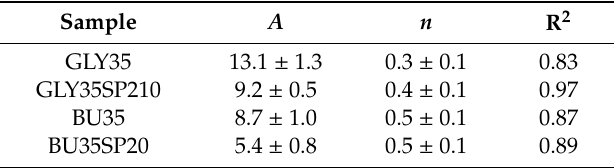
Table 3. A , n , and R-square parameters for the water absorption equation for samples with 35% of glycerol and 1,4-butanediol, with and without 20 php of microalgal biomass.